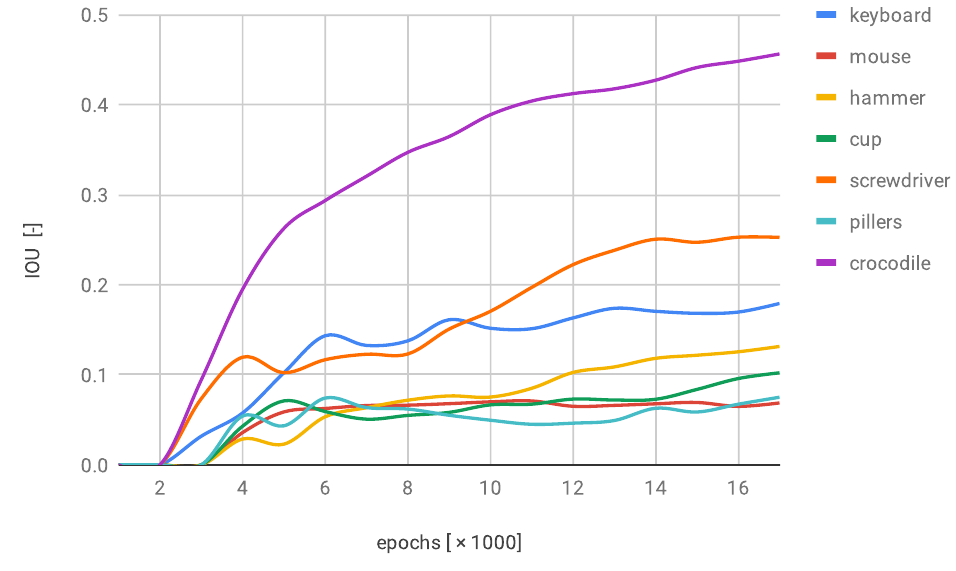
Figure 9. IOU changes over training progress on original